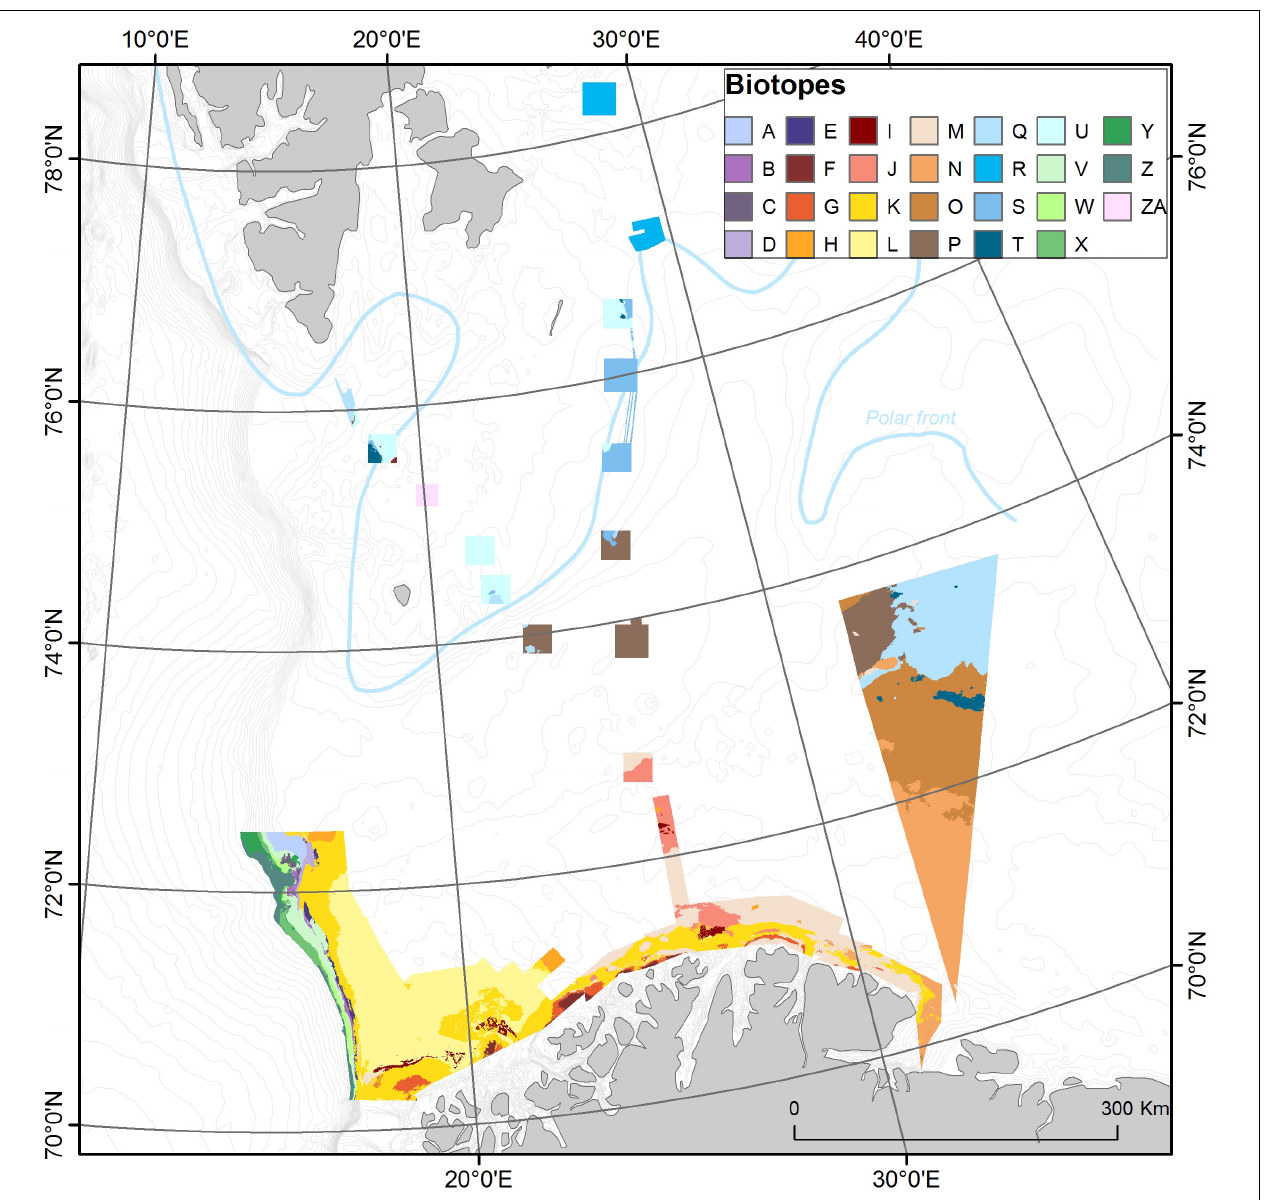
FIGURE 8 | Predicted distribution of the 27 general biotopes. Colors are roughly grouped according to the water mass splits (greens = NDSW, purples = NSAIW, yellow/browns = NAW, blues = Arctic Water). The general location of the polar front is indicated with a blue